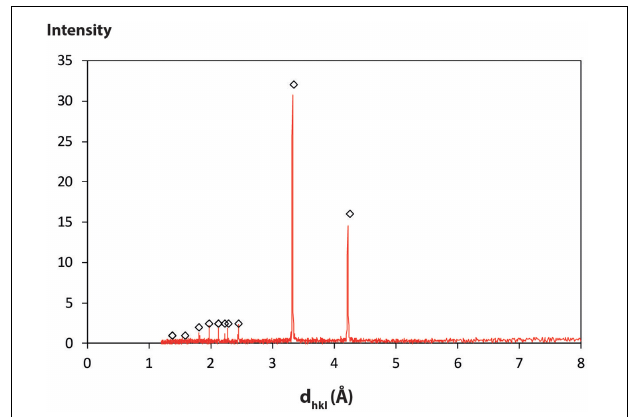
FIGURE 1 | XRD patterns of the Fontainebleau sand before the experiments. Three samples taken from the sand pool were analyzed and their respective XRD patterns overlaid perfectly on each other. Diamonds are reference values from ICDD, (1997), PDF#